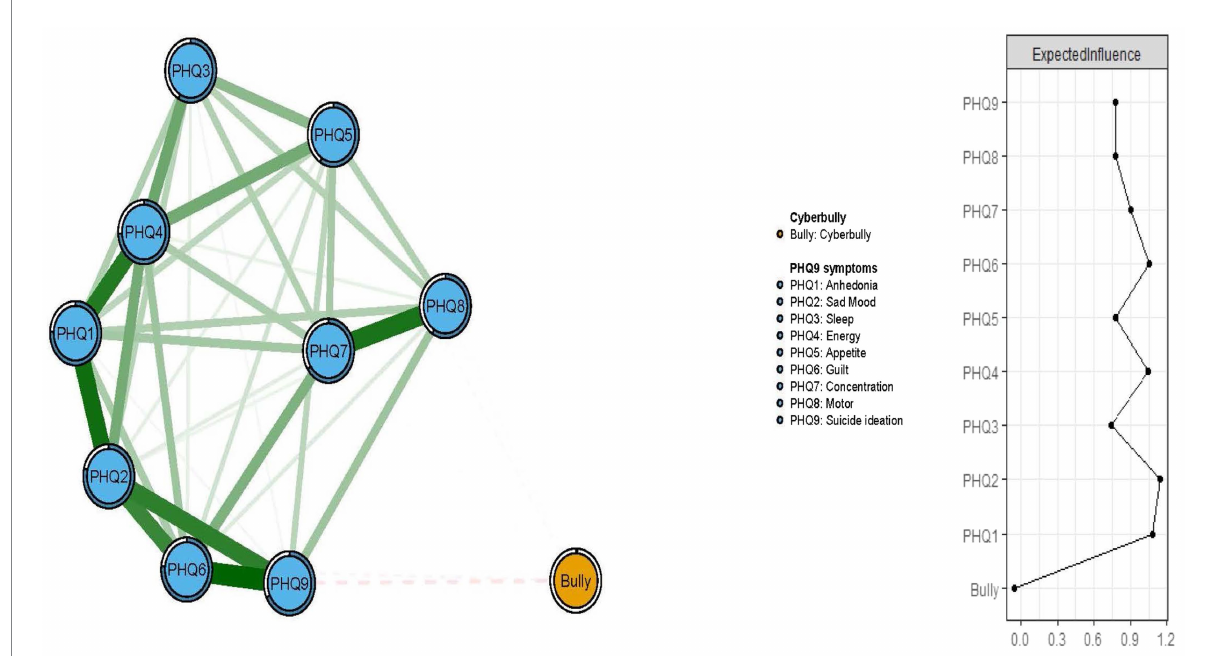
FIGURE 1 Network structure of cyberbully and residual depressive symptoms in clinically stable adolescent psychiatric